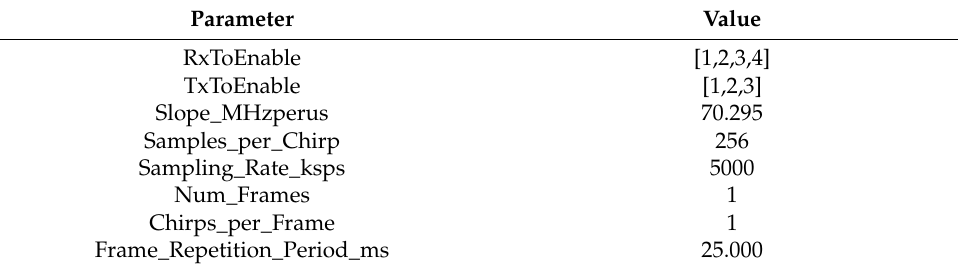
Table 3. Radar setting parameters.